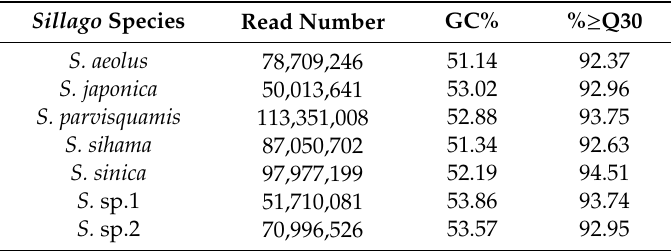
Table 2. The clean transcriptomic reads of the seven Sillago species.